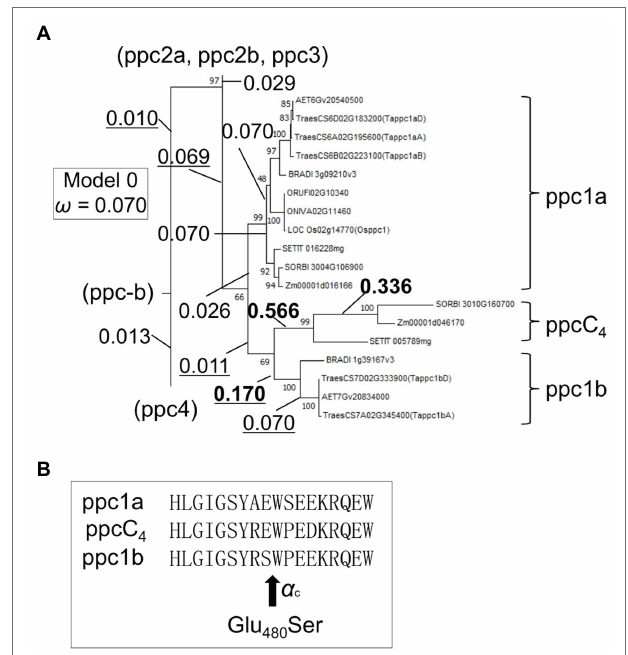
FIGURE 7 | Detected positive selection in the ppc1b and ppcC 4 lineages. (A) A partial phylogenetic tree showing ω values of branches. The ω values of the ppc1b lineage were underlined. Bold ω values represent statistical significance. (B) The positive selection site in the ppc1b branch. The amino acid positions are maize C 4 PEPC coordinate’s. α c represents the physicochemical amino acid property related to the